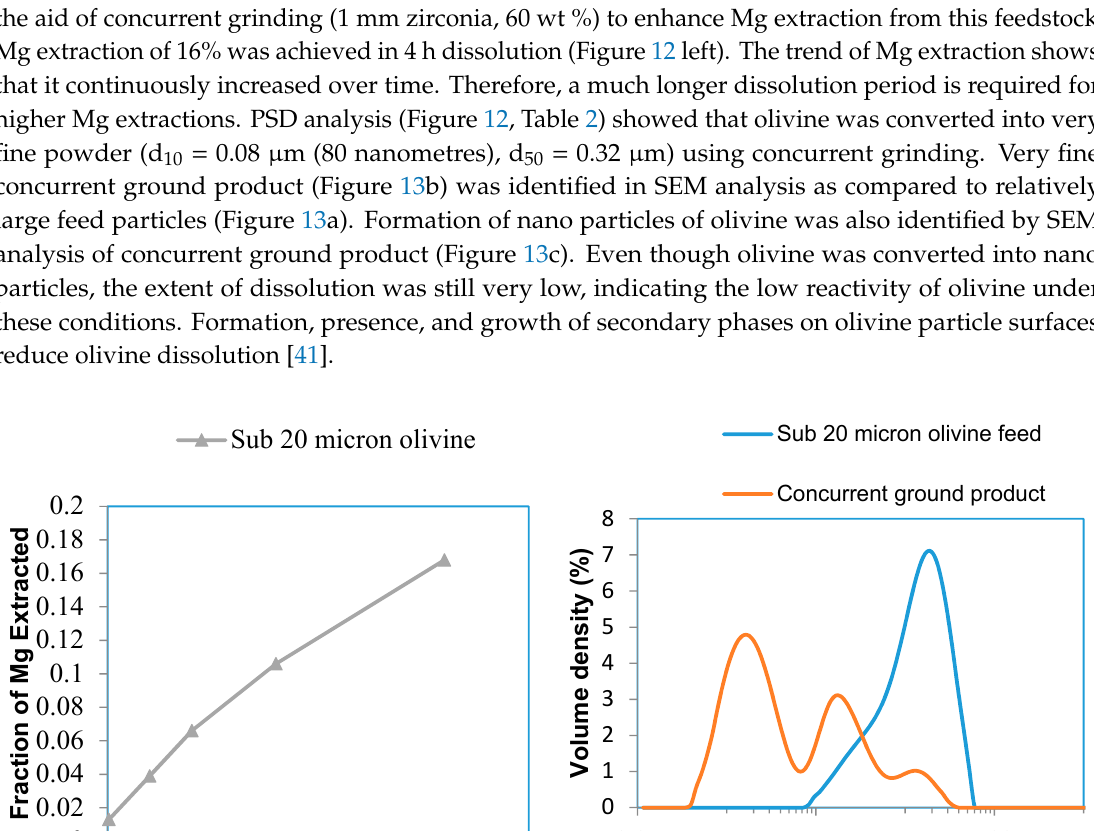
Figure 11. The Mg/Si ratio for different materials: ( a ) sub-75 µm twin sister dunite (more than 90%